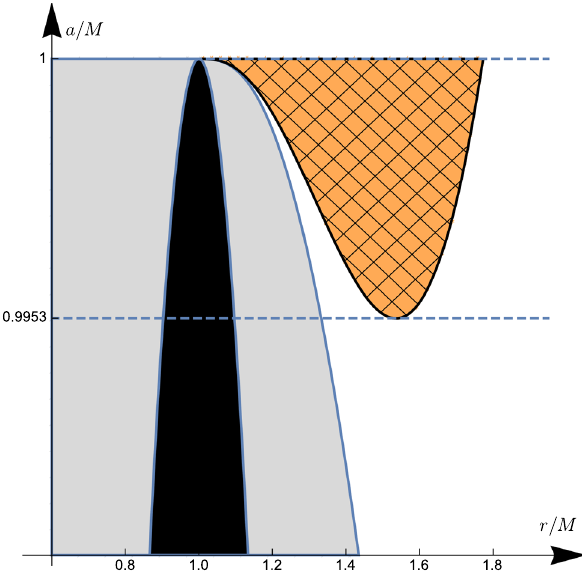
Fig. 2 The a − r parameter space, where the Aschenbach effect can be observed. For s = 0 and L = 0 the hatched region shows an allowed values of a and r for the Aschenbach effect, V + the event horizon is colored in black